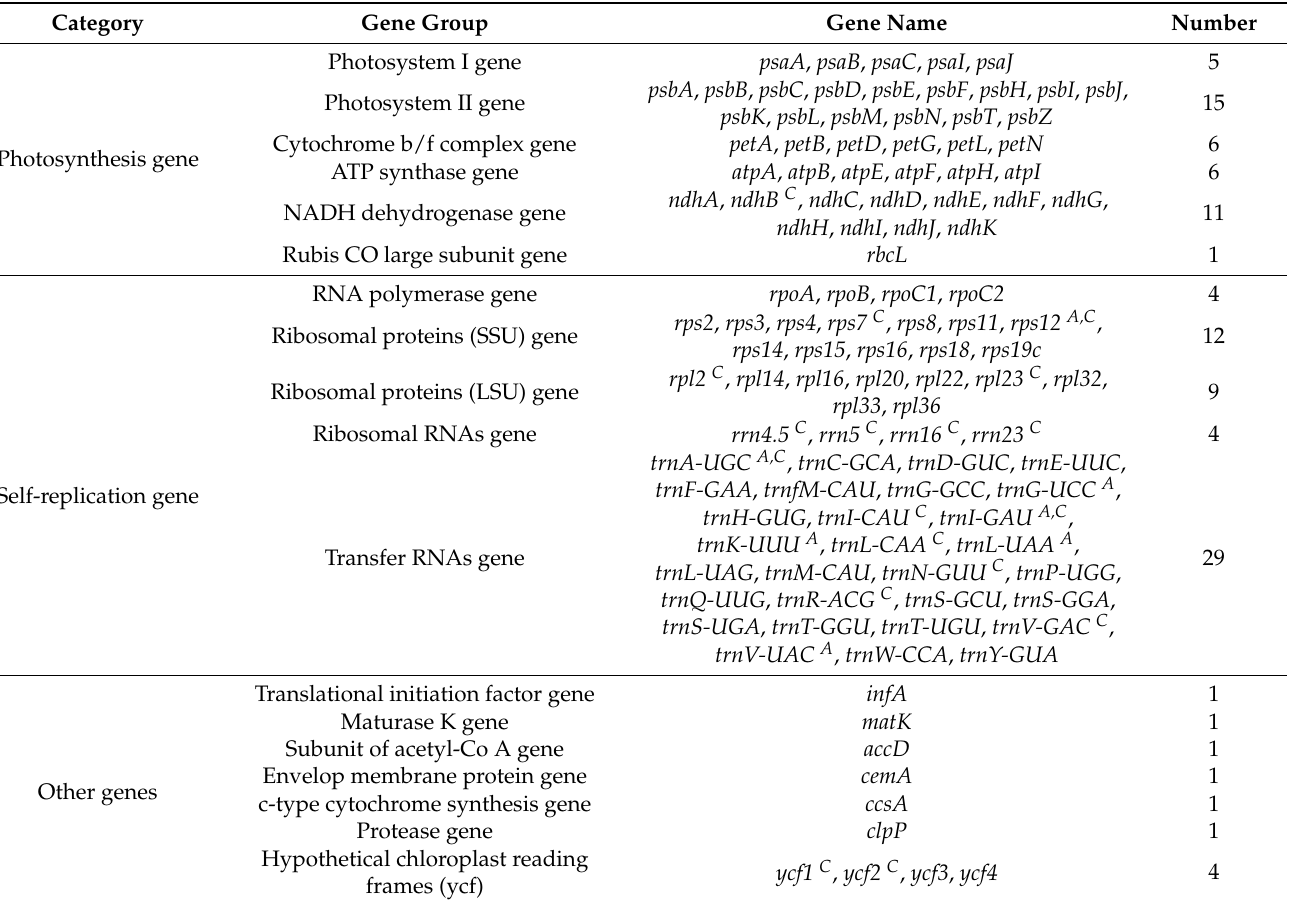
Table 2. Genes present in the chloroplast genome of R. lucieae